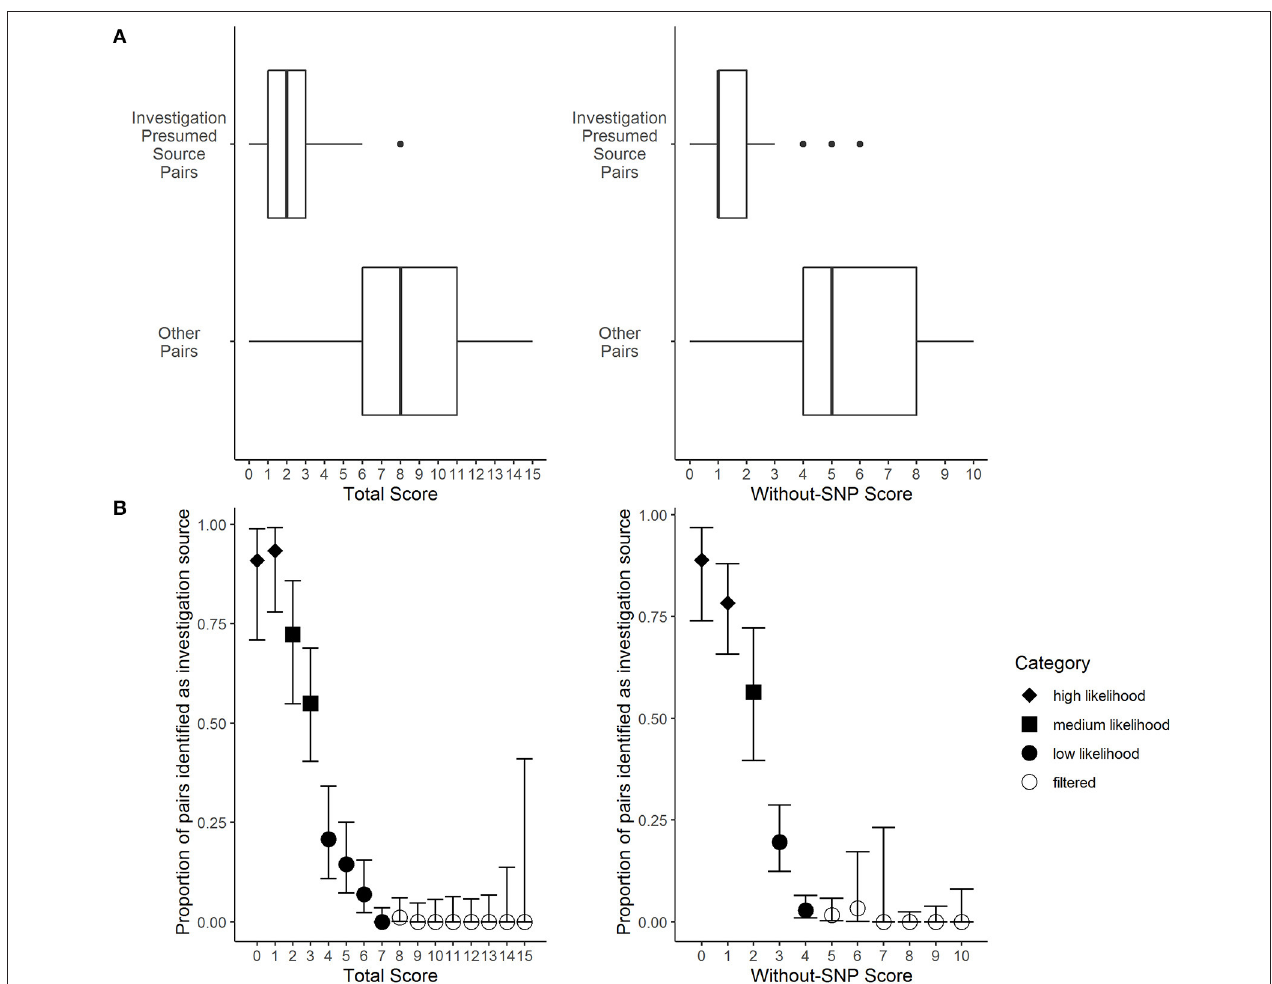
FIGURE 3 | Frequency distributions of the Logically Inferred Tuberculosis Transmission (LITT) algorithm’s scoring for TB given case-potential source pairs by local investigation presumed source determinations. Presumed source cases of Mycobacterium tuberculosis transmission identified by public health investigations conducted by the California Department of Public Health, Los Angeles County Department of Public Health, New York City Department of Health and Mental Hygiene, and their partners. Data were subset from all 873 potential sources that passed LITT’s filters for 177 given cases that had an investigation presumed source in the data set (presumed sources for four given cases had insufficient data). See Table 1 for LITT scoring system. (A) The LITT total scores (left) or without-SNP scores (right) by case pair status, where “investigation presumed source pairs” indicate presumed sources identified by the investigation and “other pairs” indicate all other potential sources that passed LITT’s filters (Wilcoxon rank sum tests, p -values < 0.0001). (B) The LITT total score (left) or without-SNP score (right), where points indicate the proportions of pairs with that score that were presumed source pairs identified by local investigation. Bars indicate 95% confidence intervals calculated